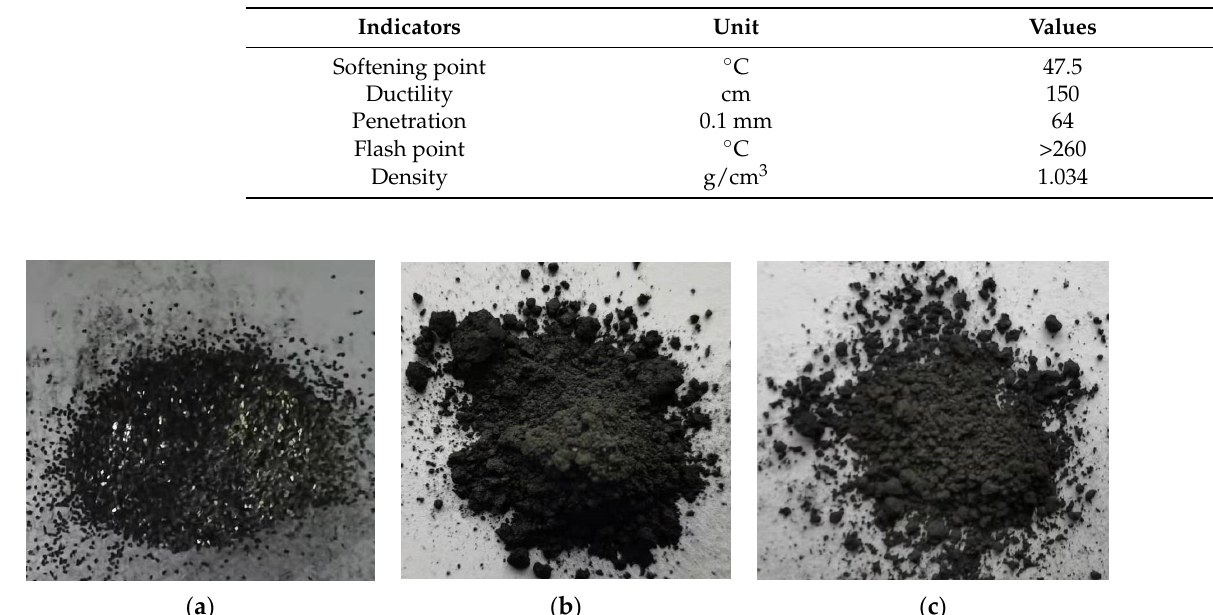
Table 1. Properties of 70# asphalt binder.